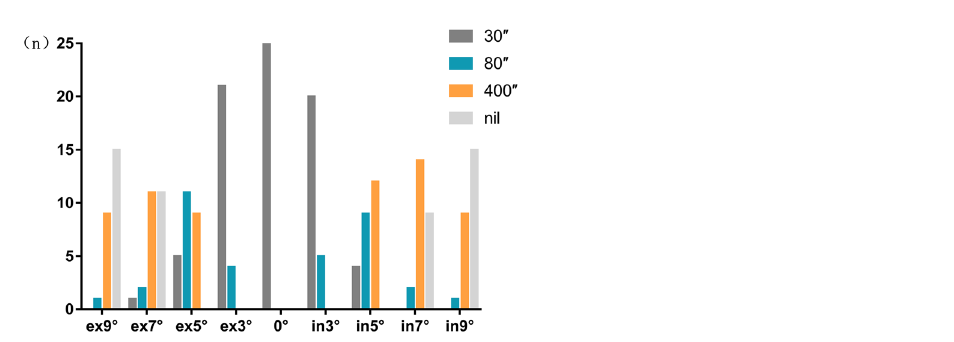
Figure 6. The proportionof the subjects having different scales of RDS at the different